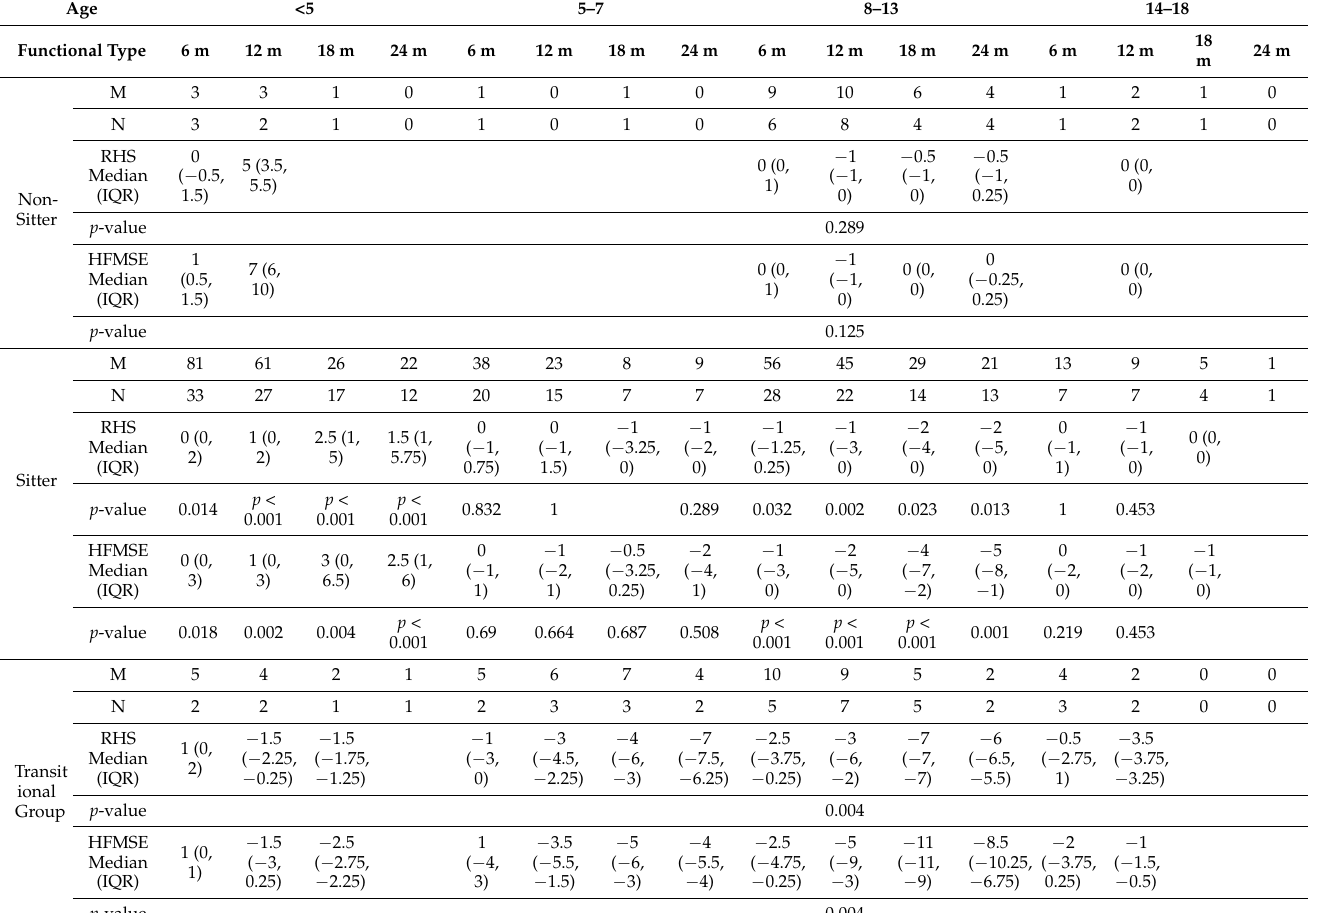
Table 4. Up to 2-year median change in the RHS and HFMSE cross-tabulated by WHO-derived functional type and age. N : number of participants, M : number of assessments, IQR : inter-quartile